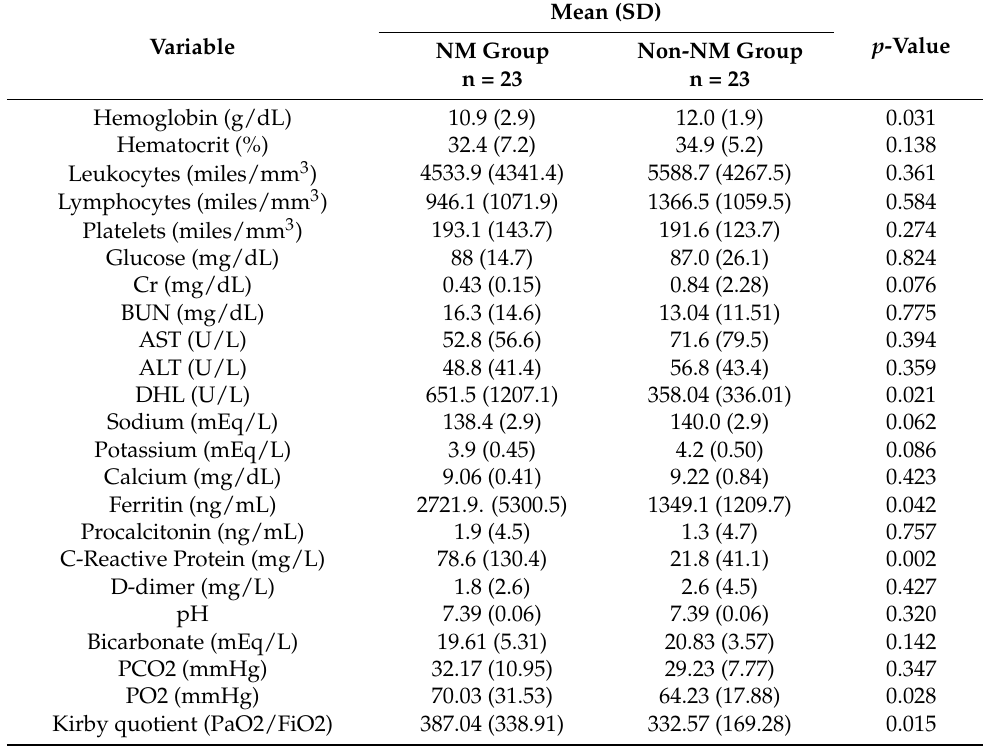
Table 4. Results of laboratory tests and organ function in pediatric patients with COVID-19.